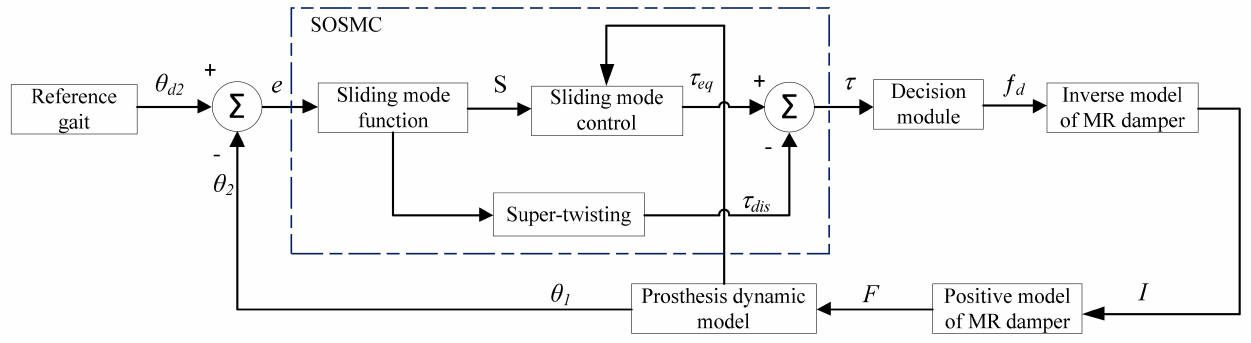
Figure 16. Principle of MR prosthesis based on